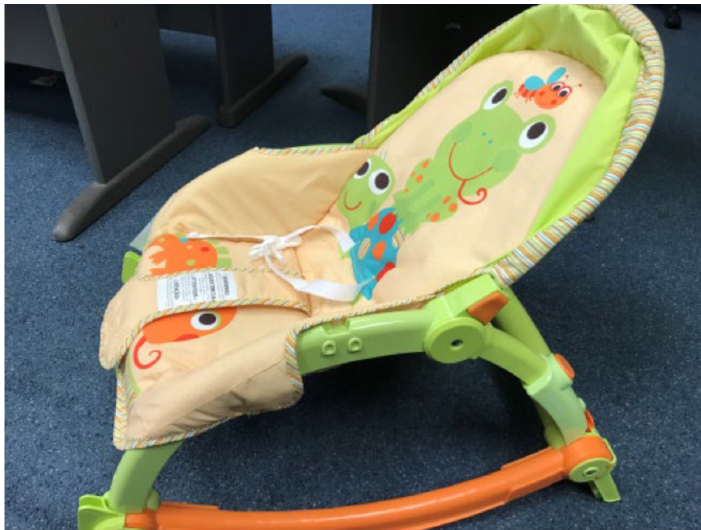
Figure 1. HUGS ‐ 1 A ‐ frame for instrumented toys.